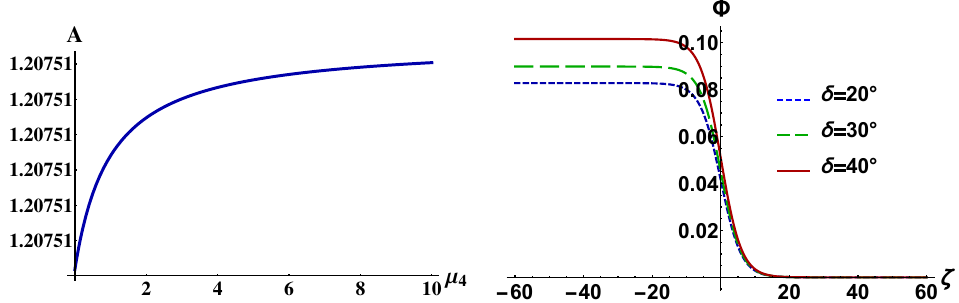
Figure 1. Plot of the nonlinear coefficient A vs. µ 4 ( left panel ) and Φ vs ζ for different values of δ ( right panel ) when α = 5/3, η = 0.3, γ e = 4/3, δ = 20 ◦ , Z 1 = 37, Z 2 = 6, n 10 = 10 29 cm − 3 , = 10 33 cm − 3 , U = 0.05, and v p = v p + . n 20 = 10 30 cm − 3 , n e 0 0